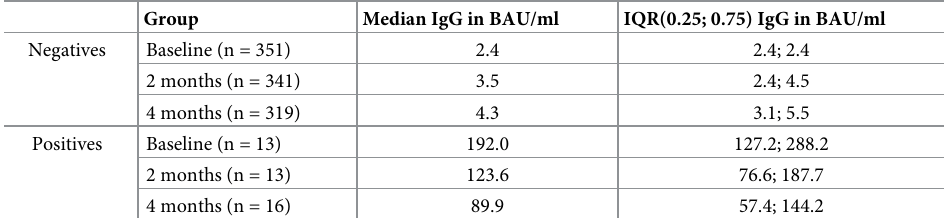
Table 3. Number of children in each violin of Fig 4, with median IgG antibody values (IQR) for each violin. Group